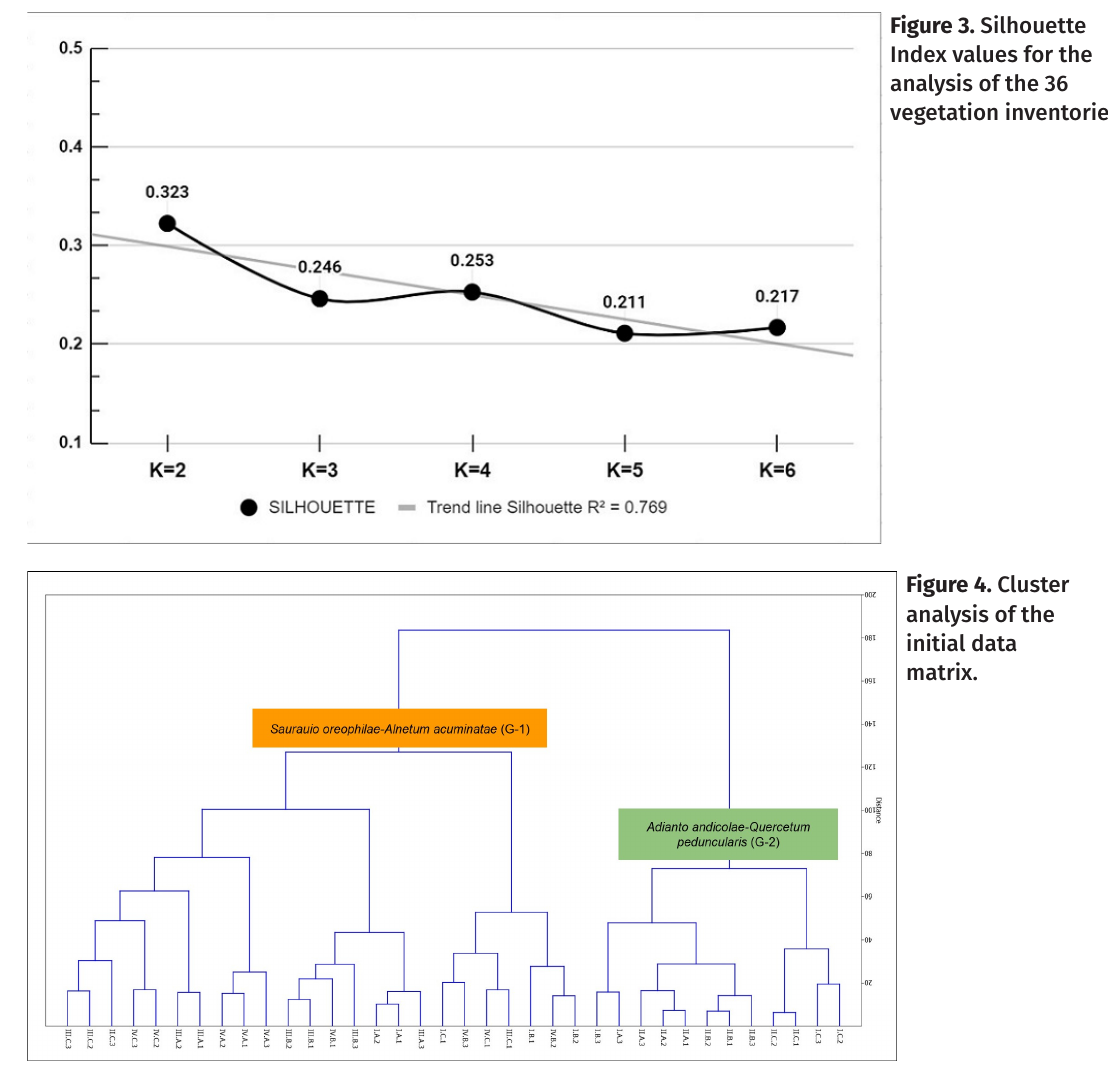
Index values for the analysis of the 36 vegetation inventories.